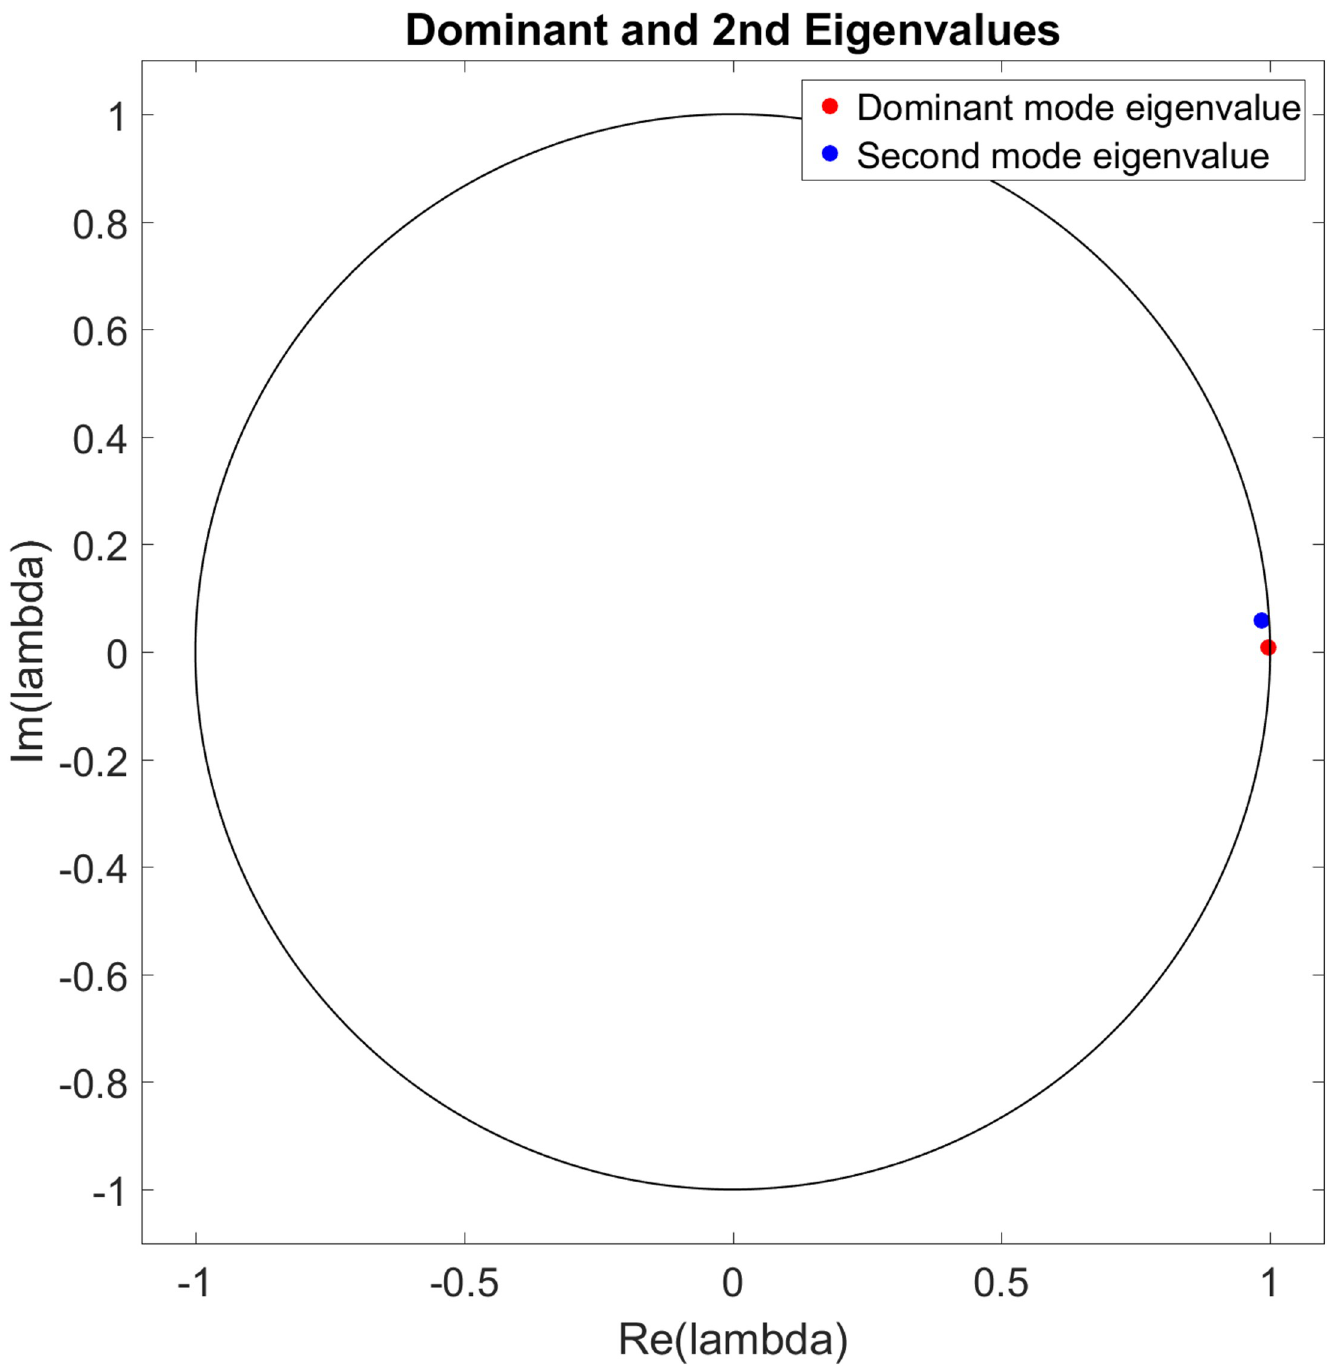
Fig 26. Example eigenvalues of the dominant and second modes from a single simulation for maximum site fuel value of 200 units. The dominant mode eigenvalue is nearly on the unit circle and the real axis, indicating little or no temporal growth/decay or oscillatory behavior, while the second mode eigenvalue is closer to the origin and off of the real axis, indicating long term decay and oscillatory behavior of the associated mode.